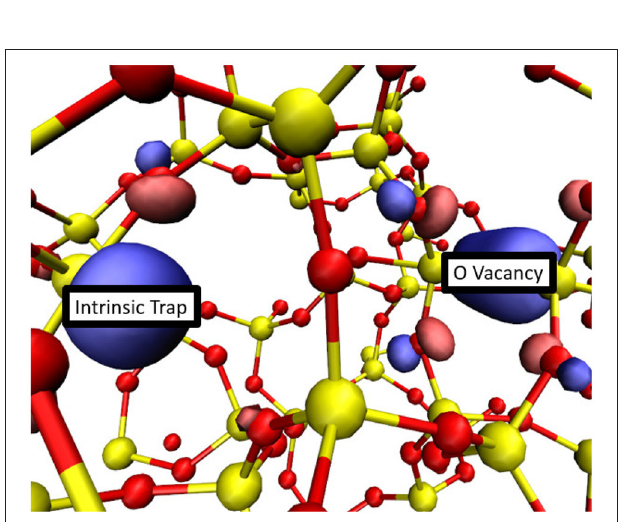
FIGURE 10 | The HOMO of a doubly negative O vacancy and a strain-induced wide O-Si-O angle intrinsic electron trap. In about 25% of geometries the third electron injected into a system which already contains a doubly negatively charged O vacancy localized onto a newly created intrinsic trap. Si atoms are shown in yellow while O atoms are shown in red. An iso-surface of the HOMO is shown in blue and pink.